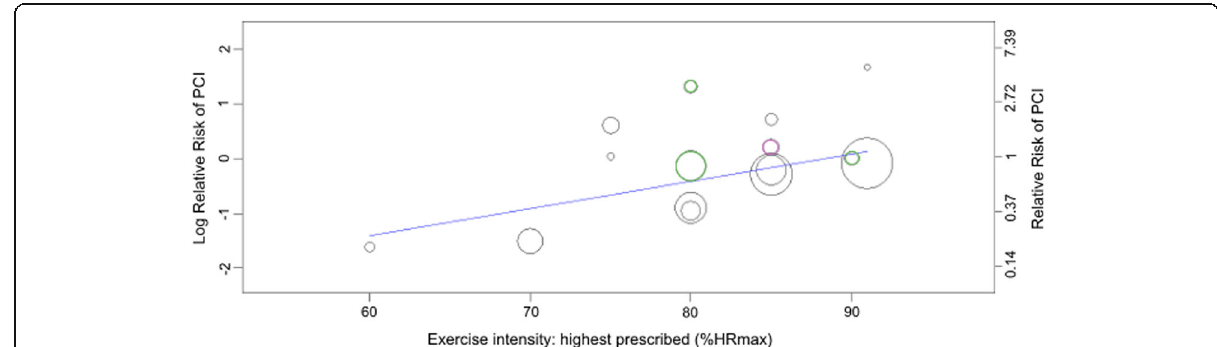
Fig. 6 Relationship between the highest intensity of exercise prescribed (as a percentage of maximal heart rate) and the relative risk of percutaneous coronary intervention compared to usual care ( p = 0.047). Each intervention is represented by a circle ; the size of the circle is proportional to the number of participants undertaking that intervention. A log RR of >0 represents an increase in risk and <0 a decrease. Circles coloured green represent interventions for which the highest intensity was only prescribed for brief periods during interval training. Circles coloured purple represent interventions for which the highest intensity was only prescribed during the work periods of circuit